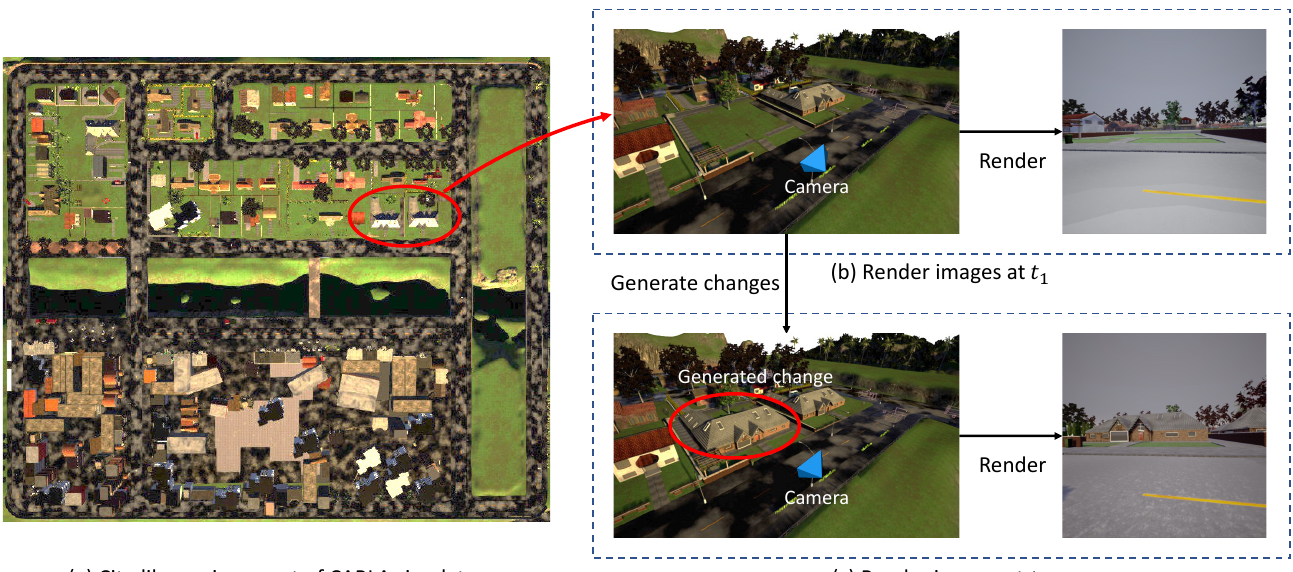
Figure 4. An overview of the data acquisition pipeline. The images were rendered from cameras that were set within the CARLA simulator